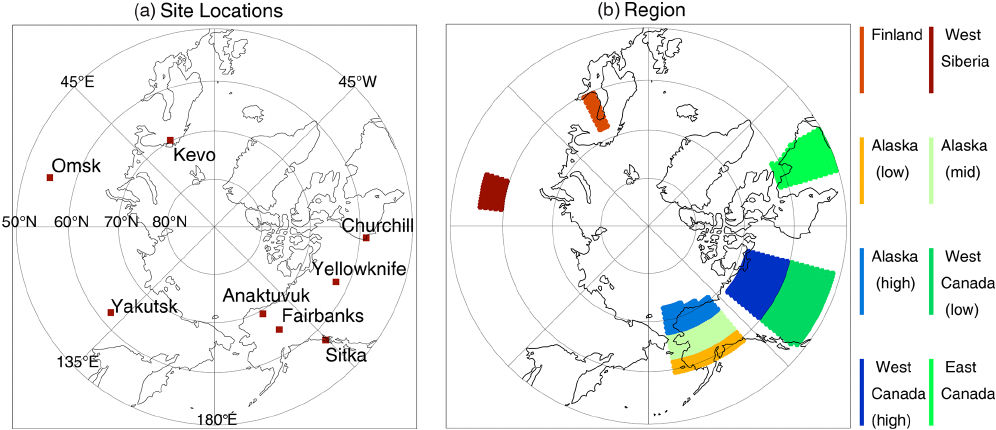
Figure 5. (a) Locations of the eight sample sites for comparison of simulated time series. (b) Areal extents of the eight subregions for analysis of the accumulation history of SOC and